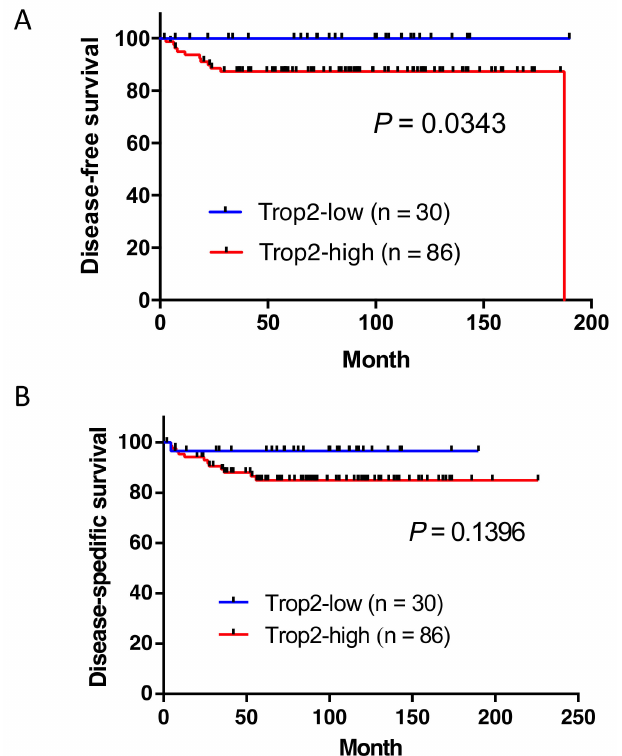
Figure 4. Kaplan–Meier survival curves of patients with Trop2-low and Trop2-high extramammary Paget disease (EMPD). ( A ) Patients with high-Trop2 EMPD had significantly shorter disease-free survival than those with low-Trop2 ( p = 0.0343). ( B ) For disease-specific survival, the difference between the two group did not reach statistical significance ( p = 0.1396). Trop2, trophoblast cell surface antigen 2.